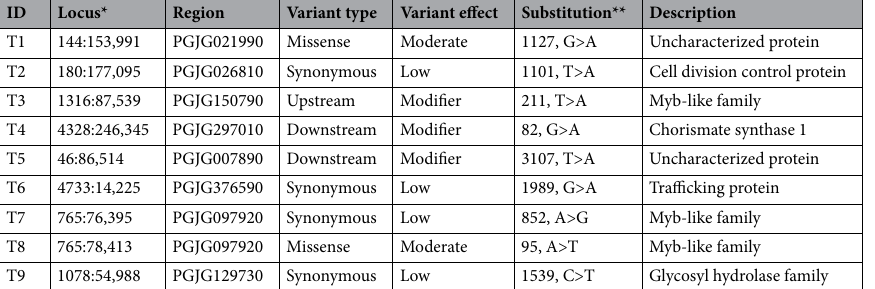
ID Locus* Region Variant type Variant effect Substitution**